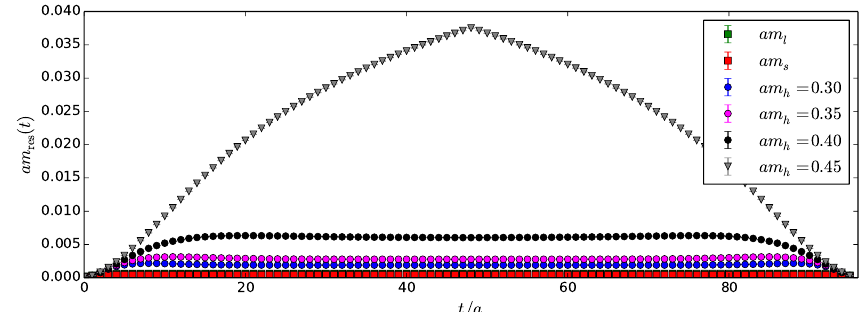
Figure 1 . The e(cid:11)ective residual mass on the C0 ensemble for all simulated masses.